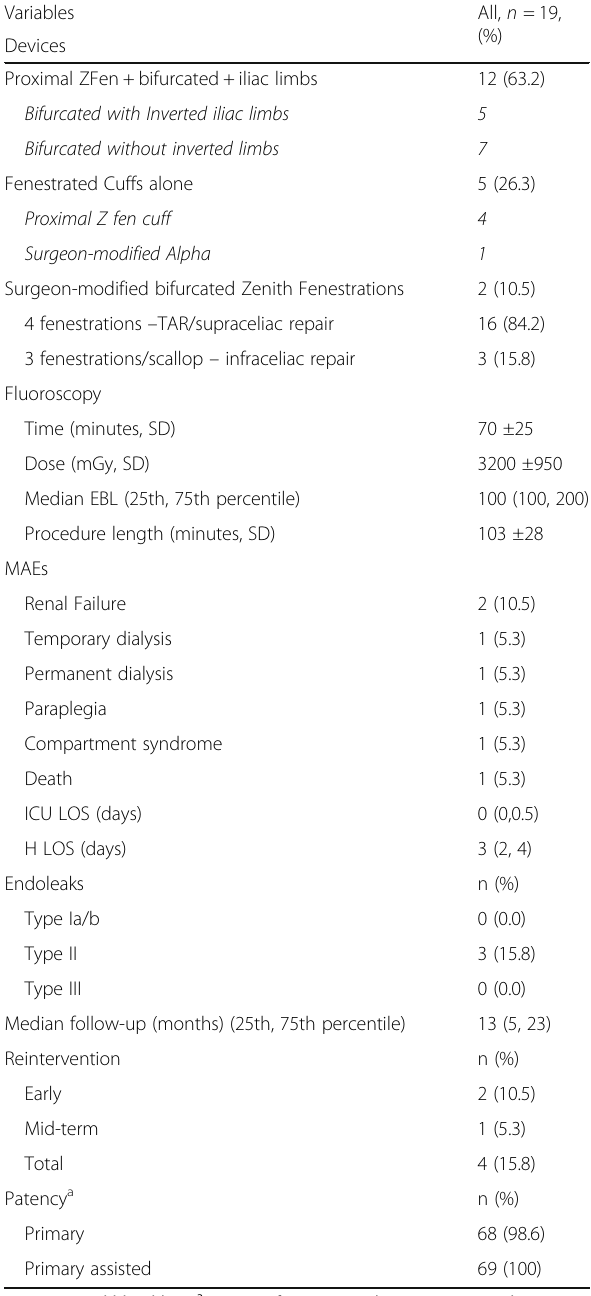
Table 5 Operative and postoperative variables